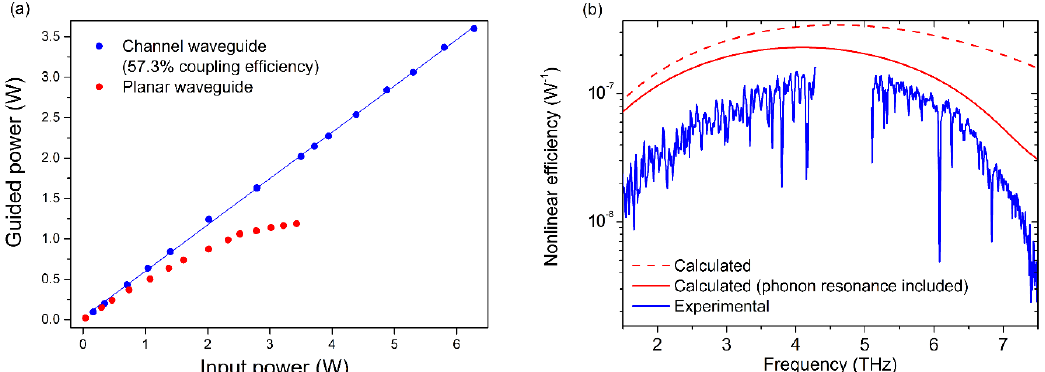
Figure 4. ( a ) Infrared power coupled to the guided mode as a function of the incoming power for a channel waveguide (blue) and a planar waveguide (red). ( b ) The red curves represent the calculated nonlinear efficiency η , with (solid) and without (dashed) the contribution of the transverse-optical phonon resonance at 7.5 THz. The blue curve is an example of the experimental nonlinear efficiency obtained with two different frequency scans. The low- and the high-frequency parts of the blue trace have been obtained by scanning the A1 amplifier from 1541 to 1563.5 nm and fixing the A2 wavelength at 1575 nm and 1605 nm, respectively.